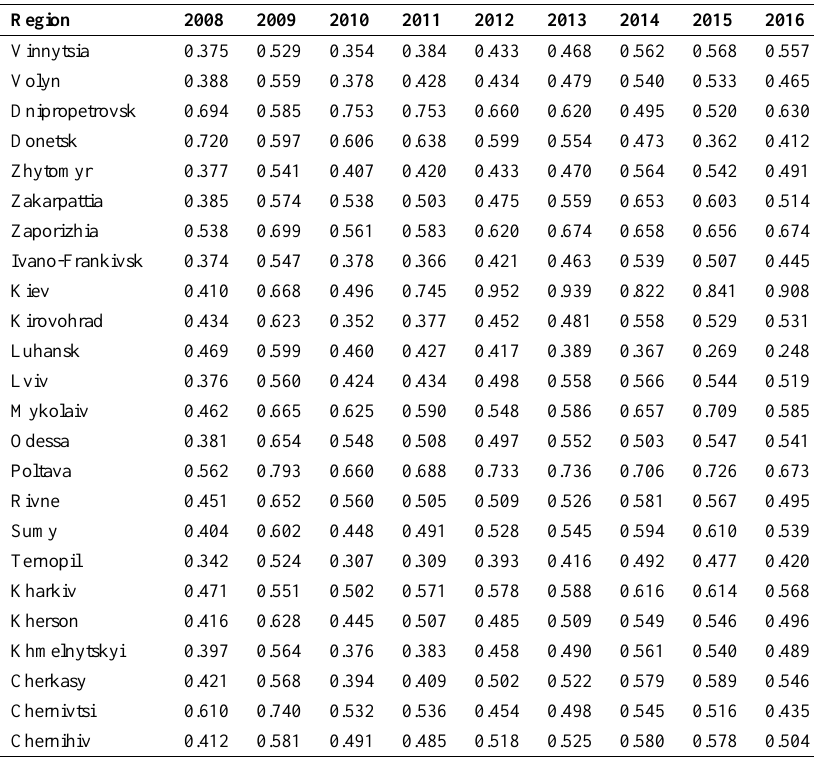
Table 2. Values of integral indicators of sustainable development of the regions in Ukraine